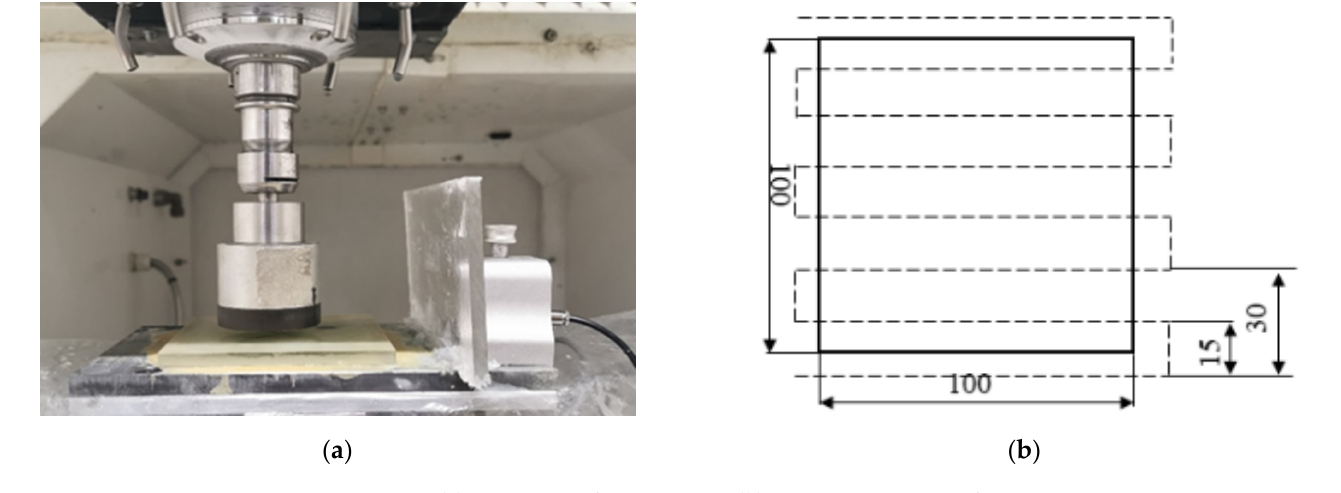
Figure 1. ( a ) experimental instruments; ( b ) grating scanning path. Table 1. Parameters of the cup wheel, workpiece and the grinding process.